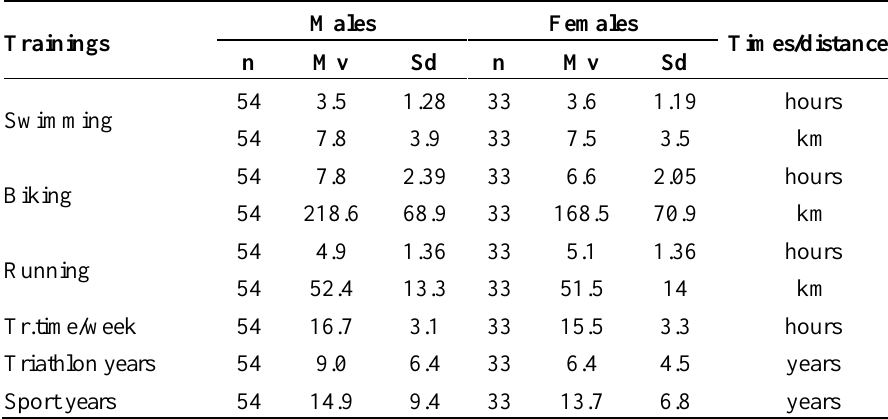
Table 9. Training